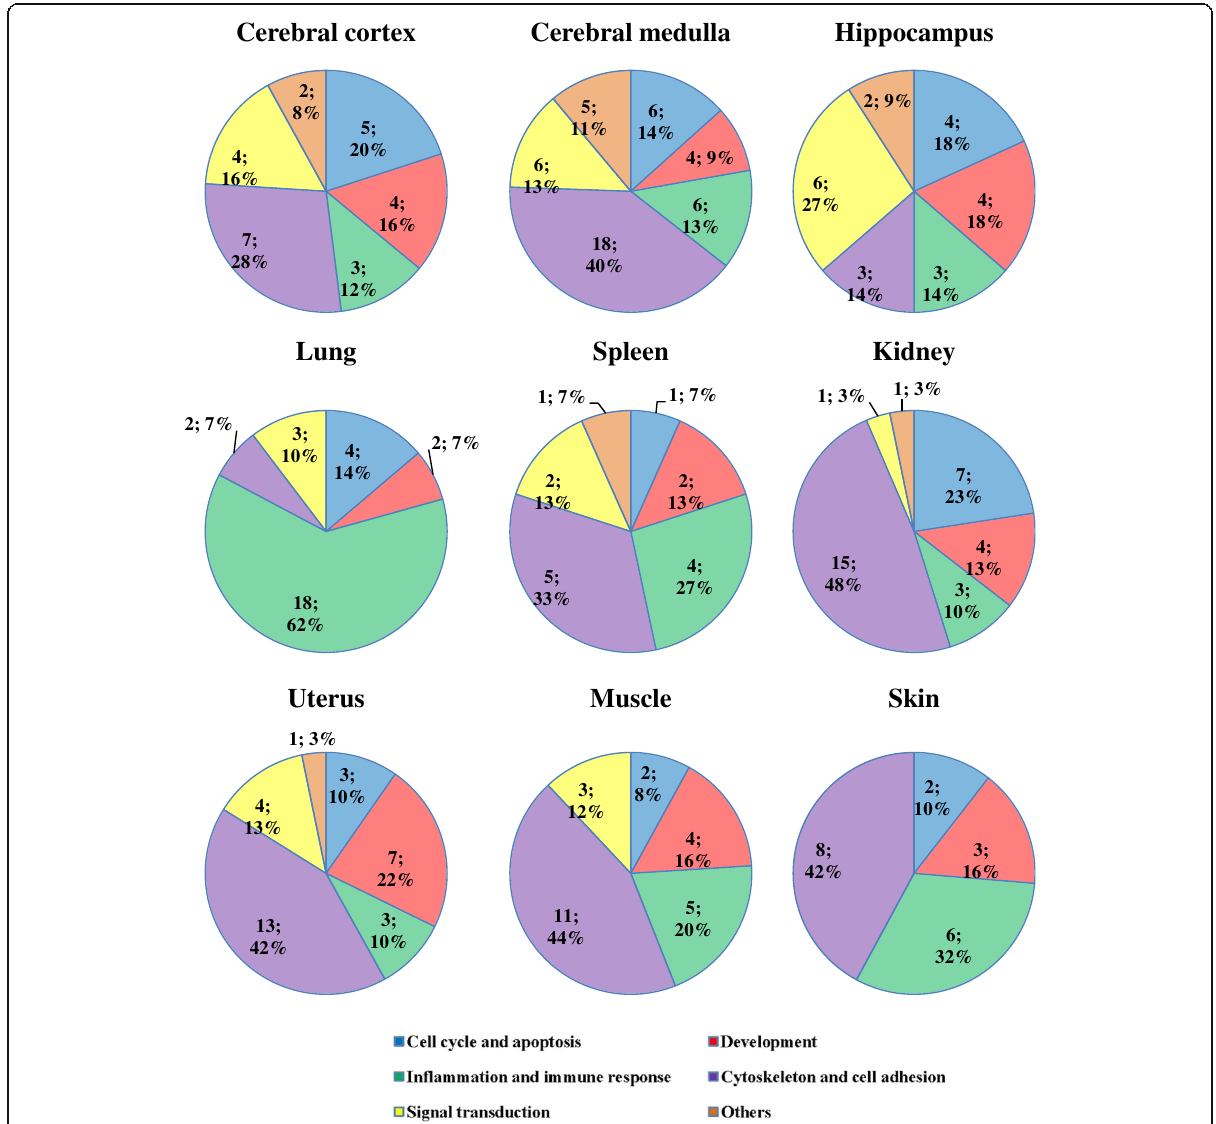
Fig. 3 Process network categories affected by EA stimulation at ST36 acupoint in various organs. Genes with fold changes ≥ 1.5 or ≤ − 1.5 were selected for the generation of process networks using MetaCore Analytical suit. Process networks were sorted into five categories and the categories were illustrated at the bottom . The pie chart sectors represent the number and the ratio of process networks in each